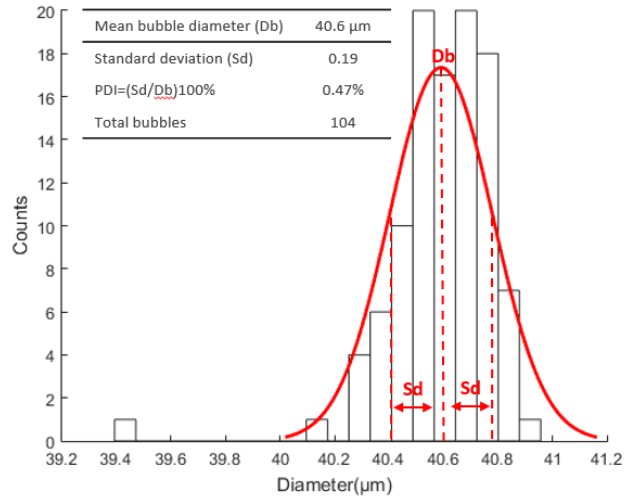
Figure 5. Microbubbles diameter distribution curve generated using the MSC-20-30 micropipette.